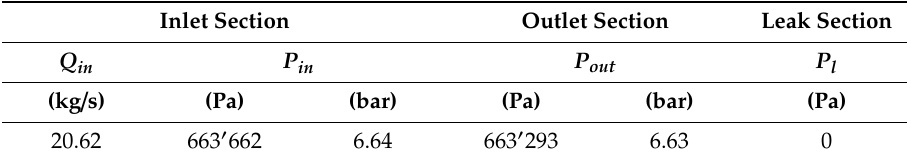
Table 6. Setting boundary conditions at Q in = 20 L / s and P = 6.54 bar.